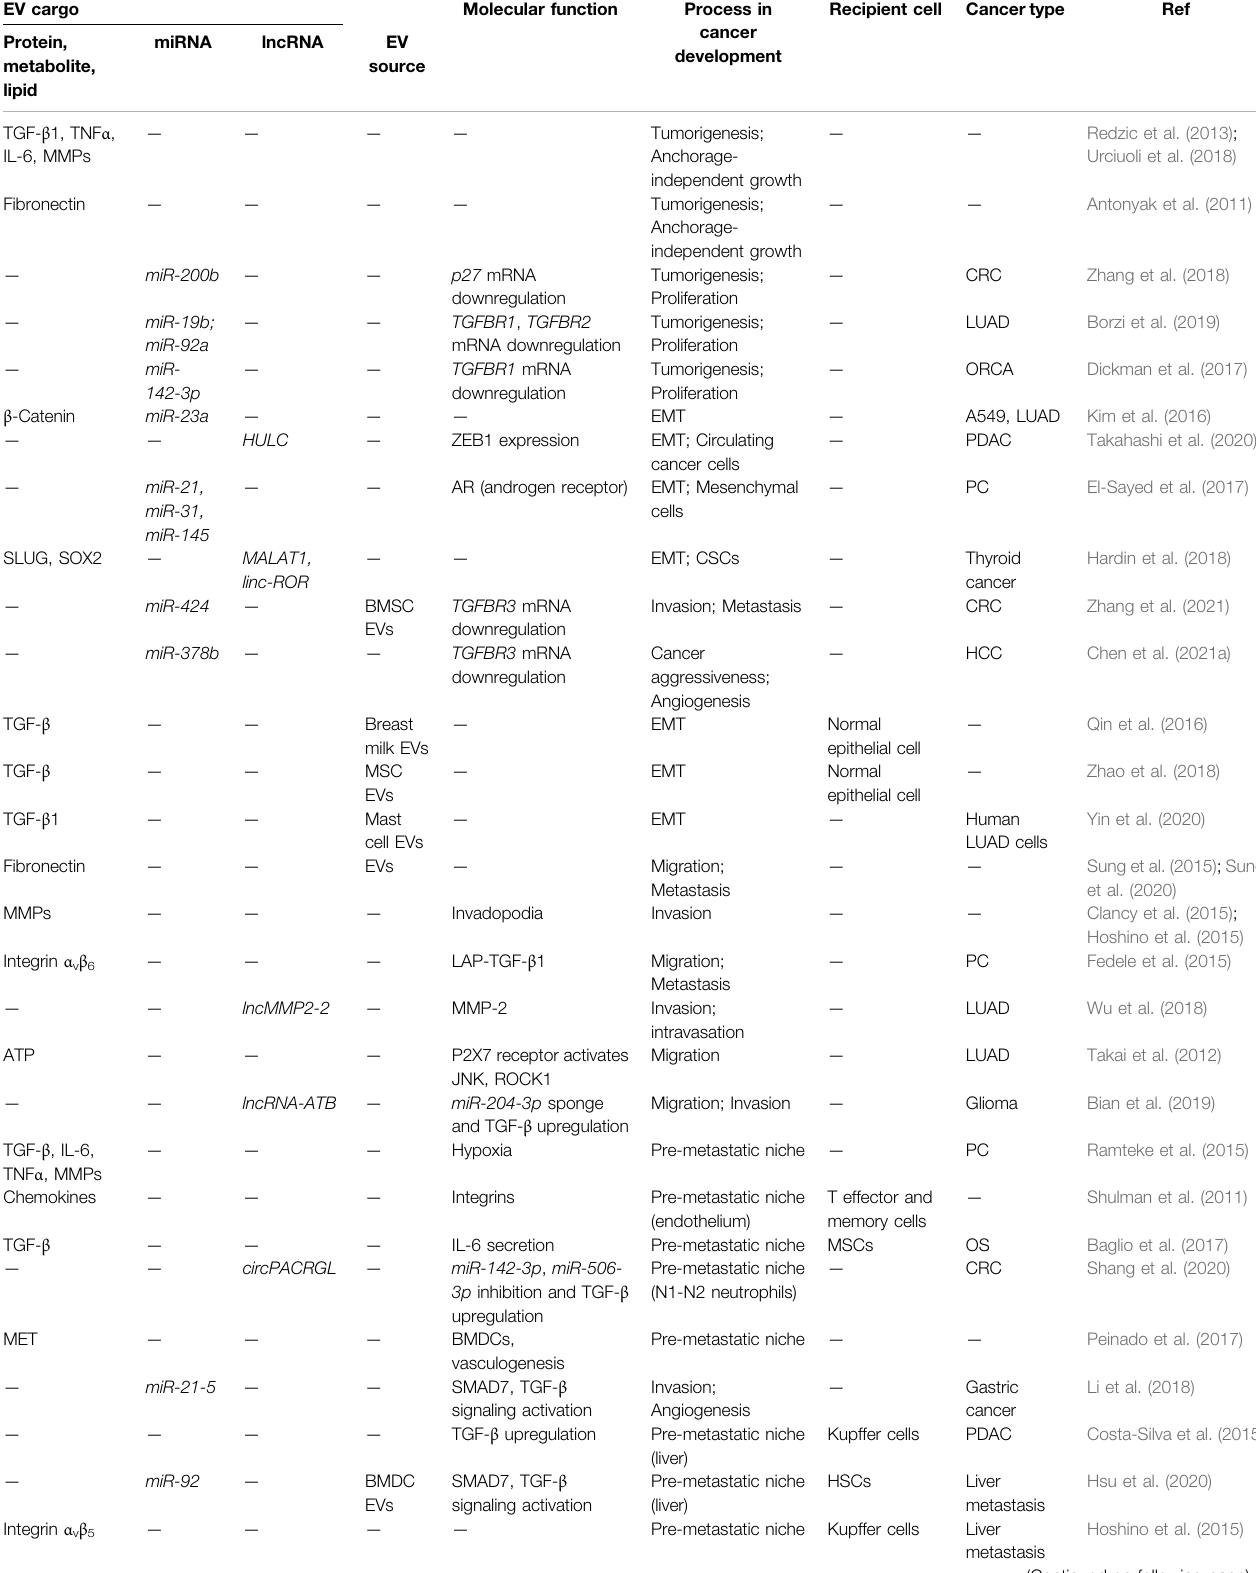
TABLE 1 | EV cargo molecules. EV